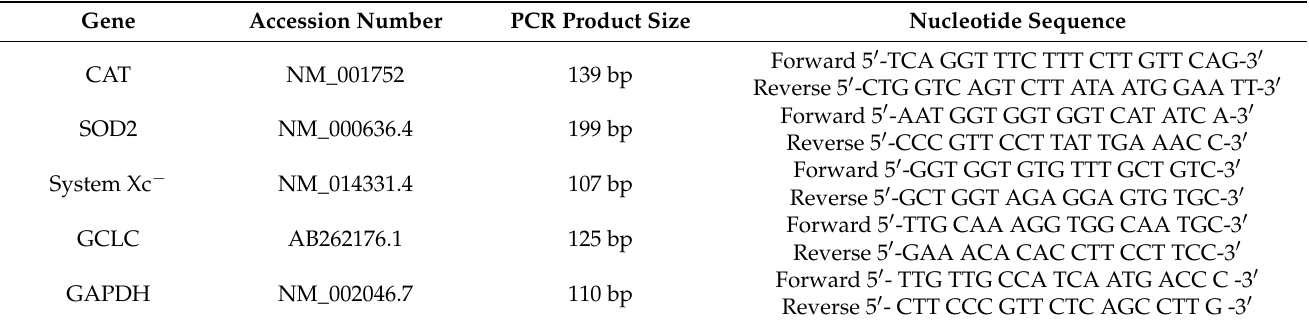
Table 1. Sequences of primers used for real-time quantitative